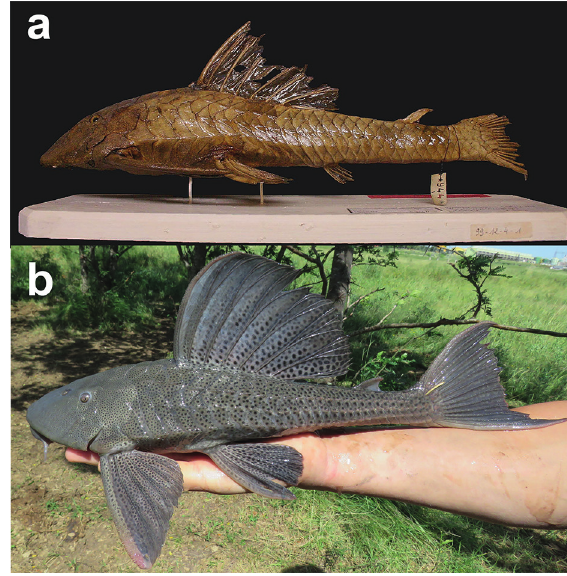
Figure 5 - Hypostomus commersoni : ( a ) holotype, MNHN A-9444, Dorsal view . (Photograph: Zawadzki, Claudio); ( b ) live specimen from Arroyo el Morejón, Campana, Buenos Aires.